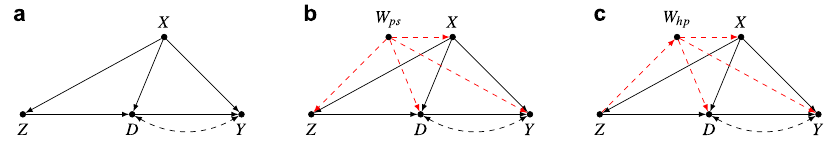
Fig. 1 Directed acyclic graphs (DAGs) illustrating the traditional MR assumptions and possible violations. Graphically, conditional on X , the genetic instrument Z is a valid IV for the causal effect of trait D on trait Y , if X blocks all paths from Z to Y on the graph where the edge D → Y is removed 4 . a Example in which the IV conditions hold, and X alone accounts for all population structure. b Here X does not account for all population structure, and valid MR requires conditioning on both X and W ps . c Similarly, here we have a violation of the standard MR assumptions due to horizontal pleiotropy through trait W hp ; again, valid MR requires conditioning on both X and W hp